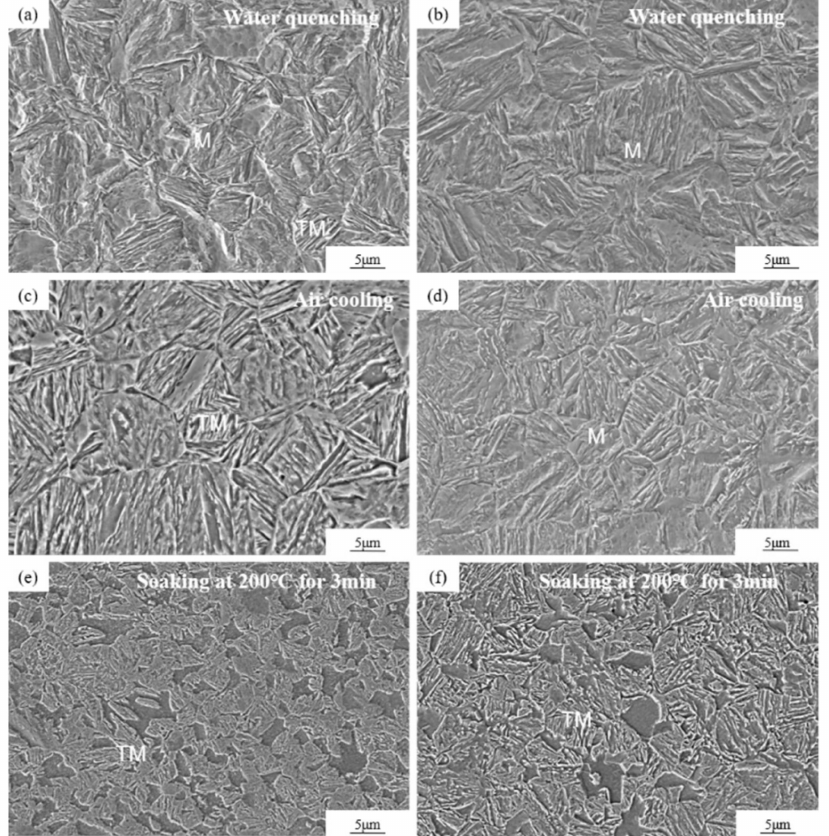
Figure 10. Microstructures of steel A ( a , c , e ) and steel B ( b , d , f ) heated to 800 ◦ C for 3 min then treated by different cooling